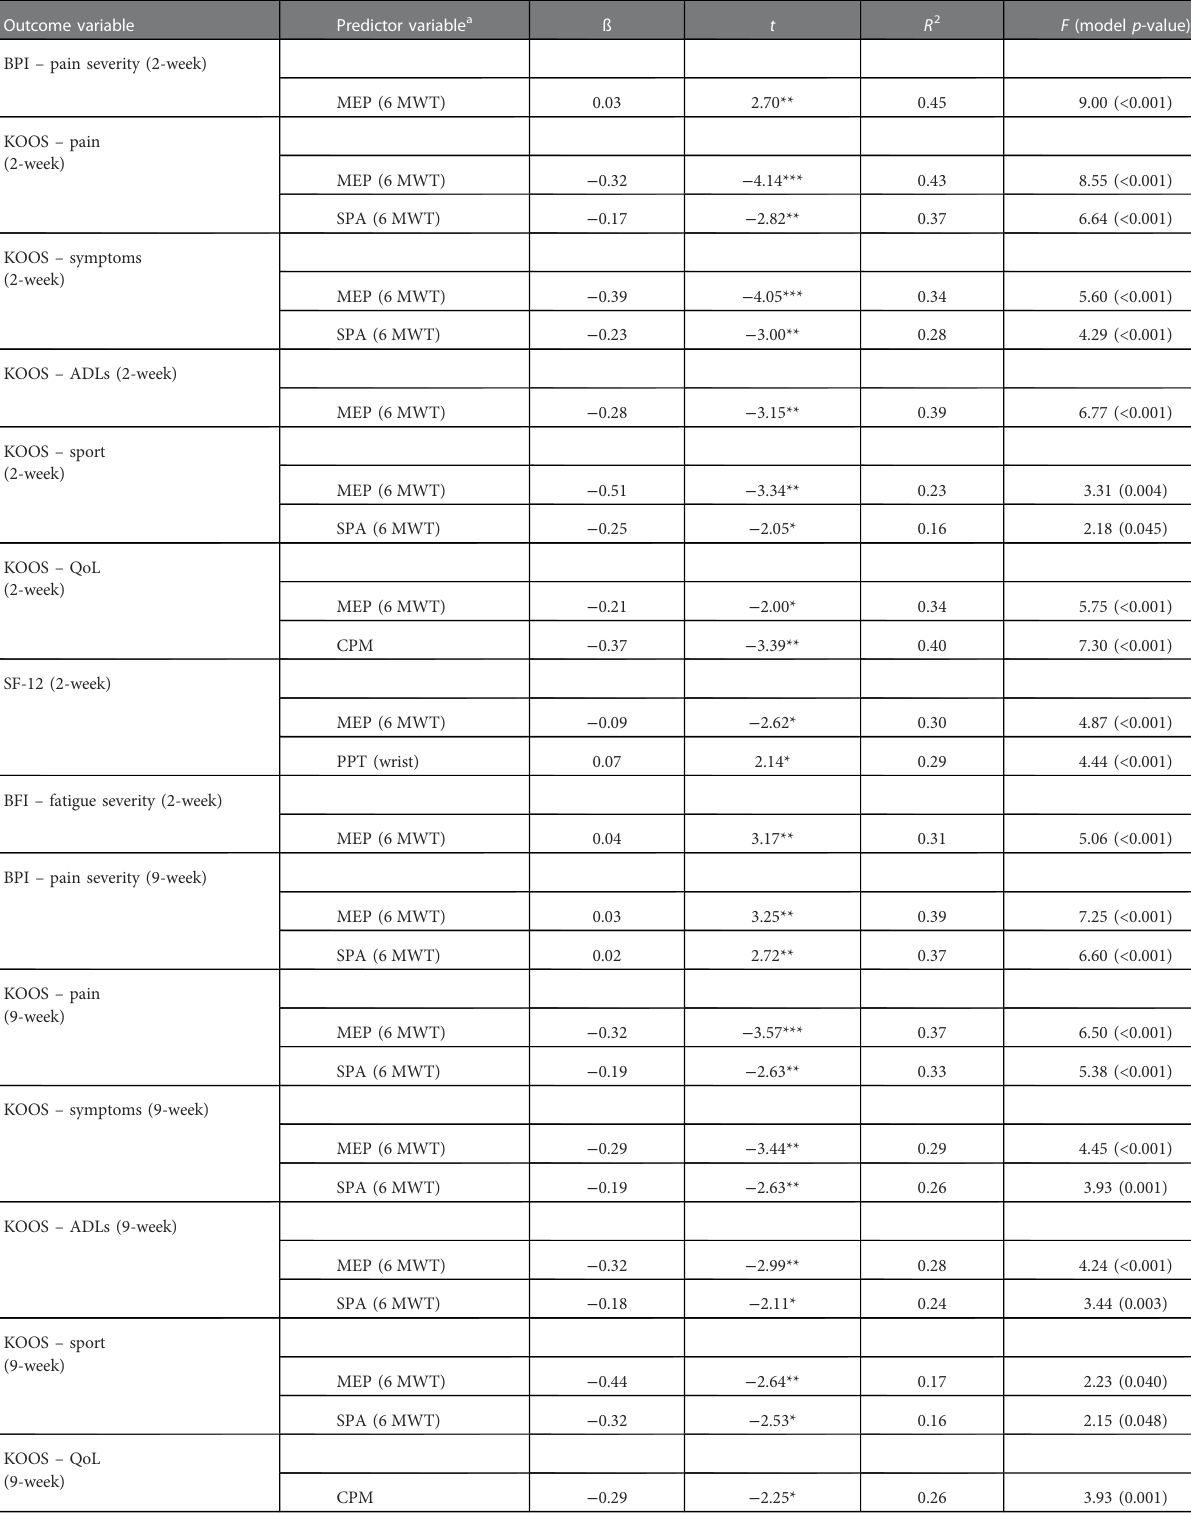
TABLE 6 Adjusted models of associations between measures of sensitization and clinical outcomes at two- and nine-week follow-ups Outcome